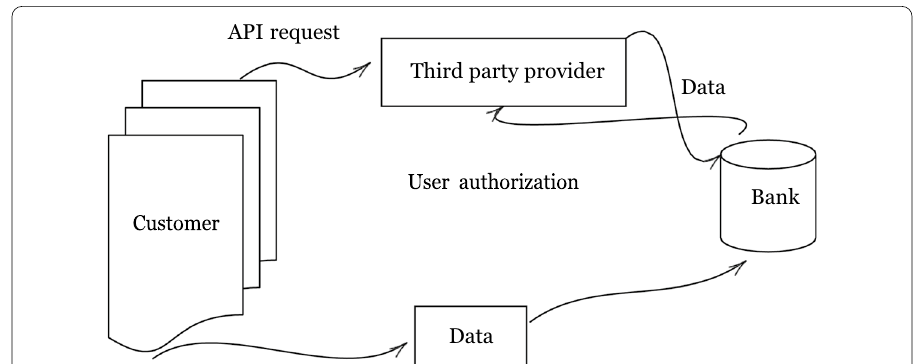
Fig. 4 How Open Banking operates. The customer generates data by using his bank account. A third party provider is authorized to access that data through an API request. The bank confirms digitally that the customer has authorized the exchange of data and then fulfills the